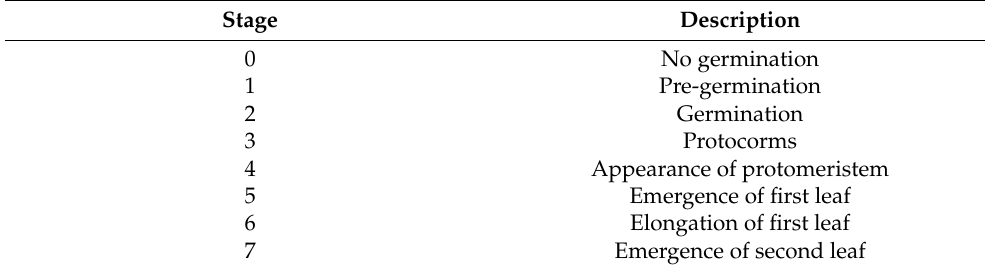
Table 2. Seedling developmental stages of Anacamptis longicornu and Ophrys panormitana [21].